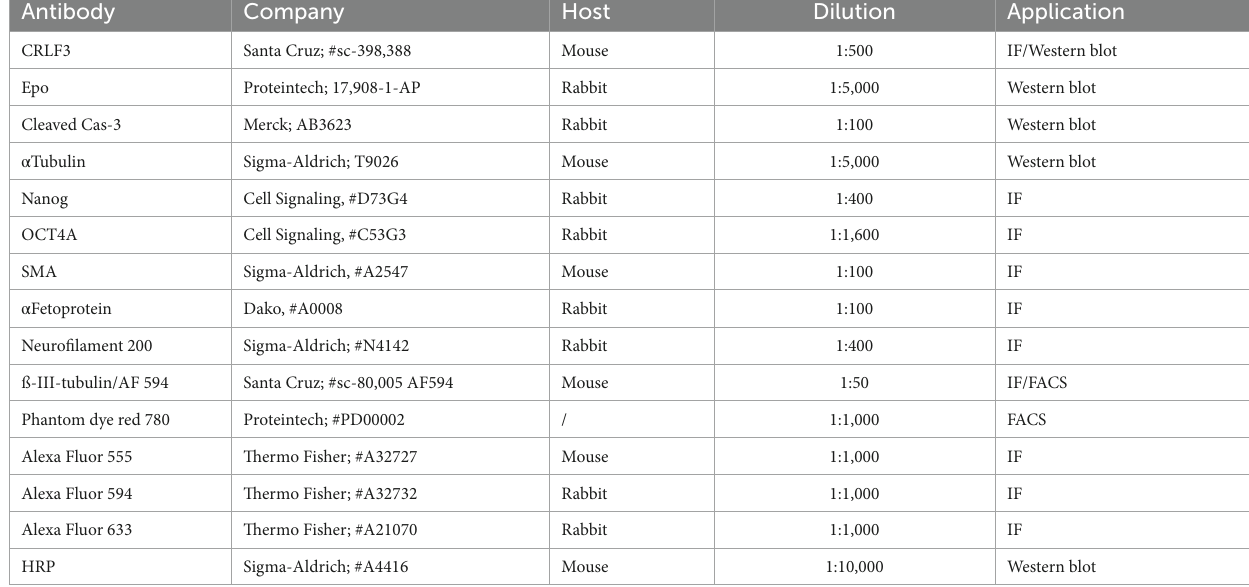
TABLE 3 Antibodies